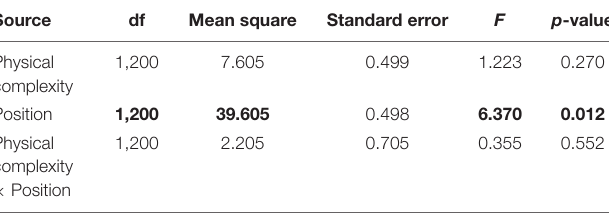
TABLE 2 | Linear mixed effect modal comparing seeded oyster survivorship between crevices and ridges (position) of 2.5 and 5 cm complex tiles.